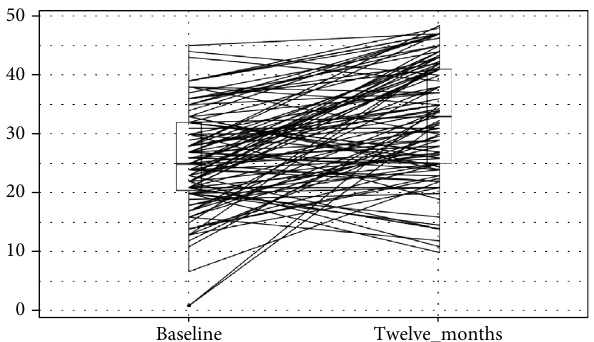
Figure 2: Oxford Knee Scores at baseline and at twelve months follow-up. y -axis: Oxford Knee Score (OKS) for function value; boxplot showing L-estimators: maximum (45), minimum (1), median (25), and interquartile range (11); outliers plotted as individual points at baseline and maximum (47), minimum (10), median (33), and interquartile range (16); outliers plotted as individual points at 1 year follow-up. x -axis: Oxford Knee Score (OKS) for function at preoperative baseline and at twelve months follow-up. Connecting lines: heuristic visualization of single-